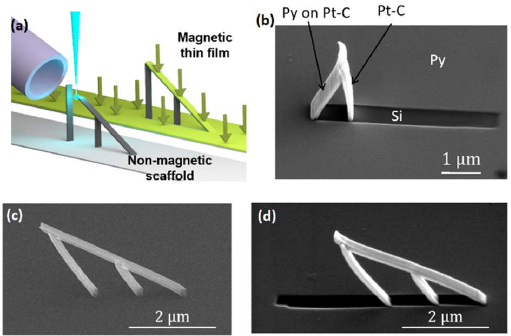
Figure 9. Thermal evaporation of magnetic thin films. ( a ) Process summary: a scaffold is 3D nano-printed (left), followed by the evaporation of a magnetic thin film perpendicularly to the substrate (right); ( b ) SEM image of a 3D nanostructure, result of thermal evaporation at 60° to the substrate; Permalloy (Py) is observed as a light grey layer on top of the Si substrate and the Pt-C scaffold. Evaporation occurred from left-to-right, perpendicular to the nanostructure, casting a shadow onto the Si substrate. ( c , d ) 3D nanowire grown at 30° to the substrate before ( c ) and after ( d ) Py evaporation perpendicular to the nanowire, evaporation occurring from right-to-left.